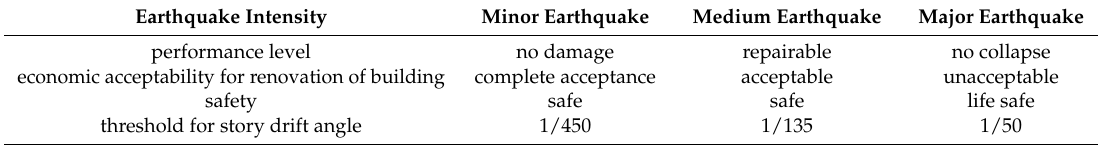
Table 3. The quantitative value for seismic performance objectives of SRHPC frame structures.